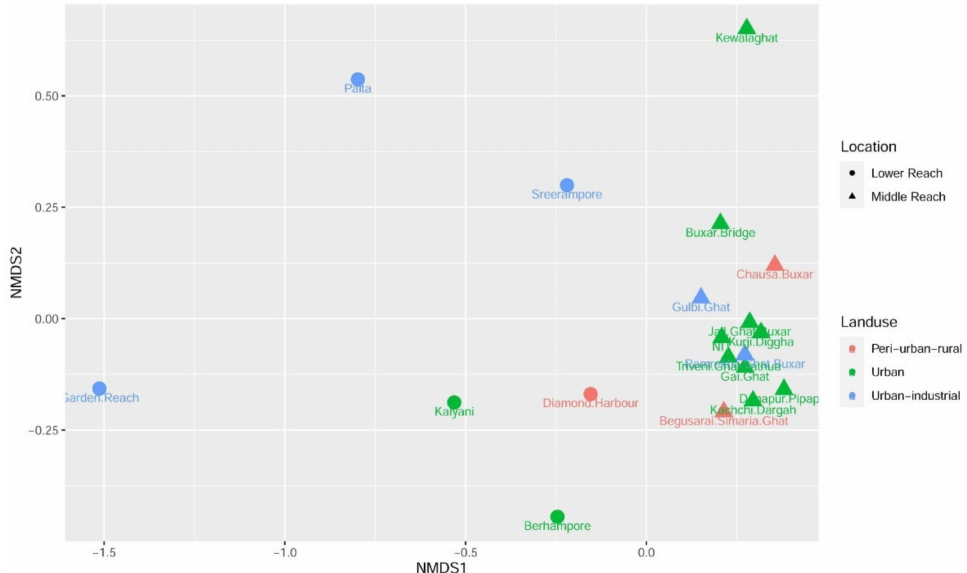
Figure 7. Non-metric multidimensional scaling (NMDS) of the Euclidean distance of the four measured parameters (pH, BOD, COD, and fecal coliform) during lockdown across all the locations from the lower and middle reaches of the Ganges